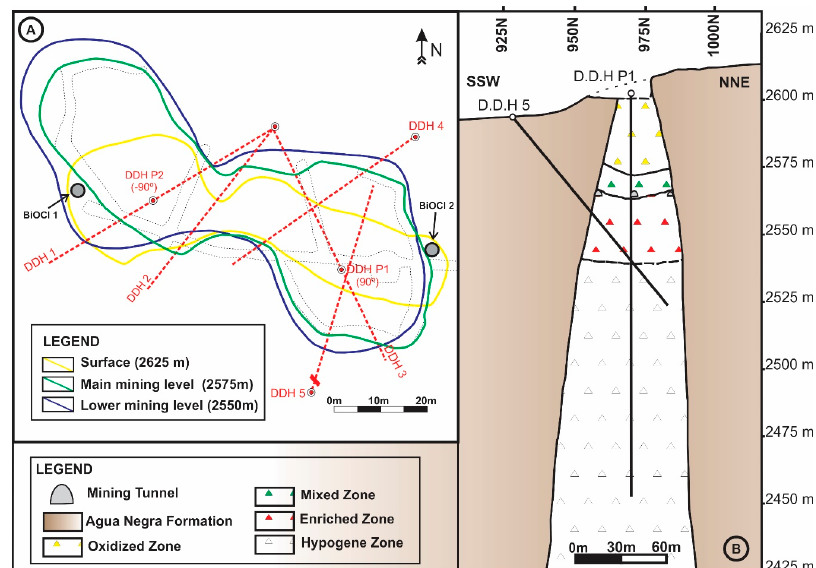
Figure 2. ( A ) Outline of San Francisco de los Andes breccia body as a function of depth (three horizontal sections). Note the location of the two representative bismoclite samples collected from the